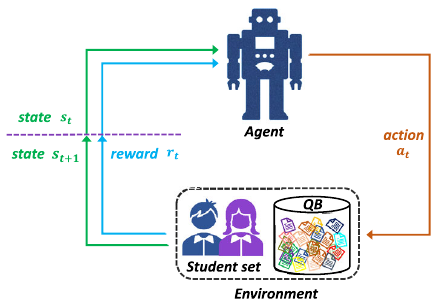
Fig. 2 The MDP process for agent–environment interaction